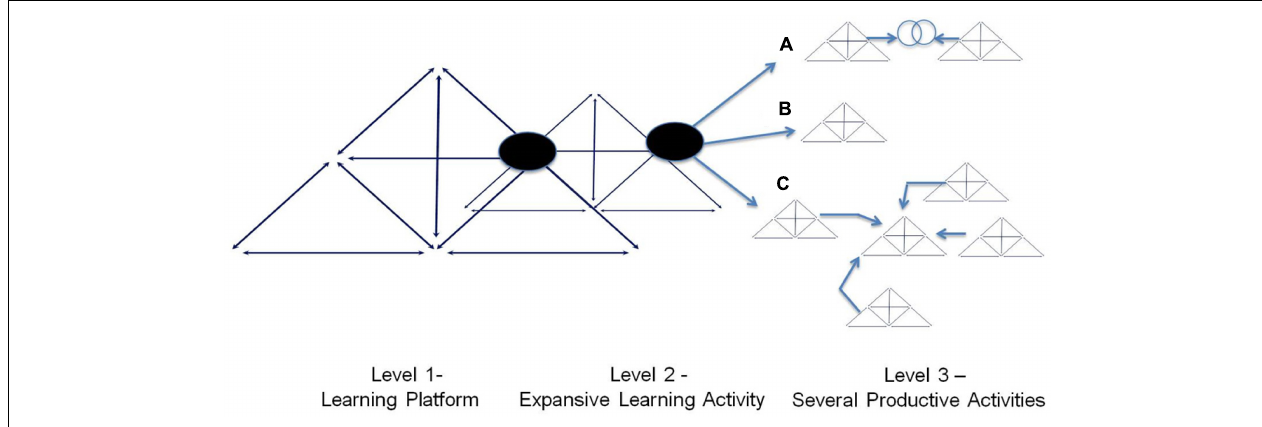
FIGURE 1 | The relationship between the learning platform and expansive learning activity: Applying the Change Laboratory method to productive activity. (A) Change Laboratory (CL) boundary crossing, (B) CL within single activity systems, and (C) CL within a network of activity